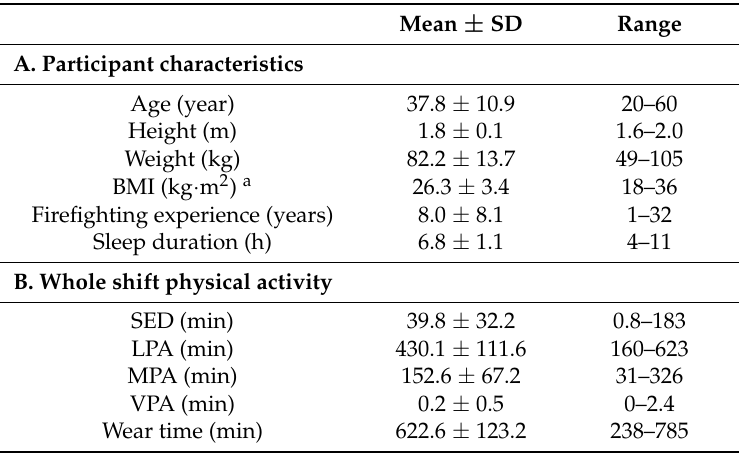
Table 1. Participant and study